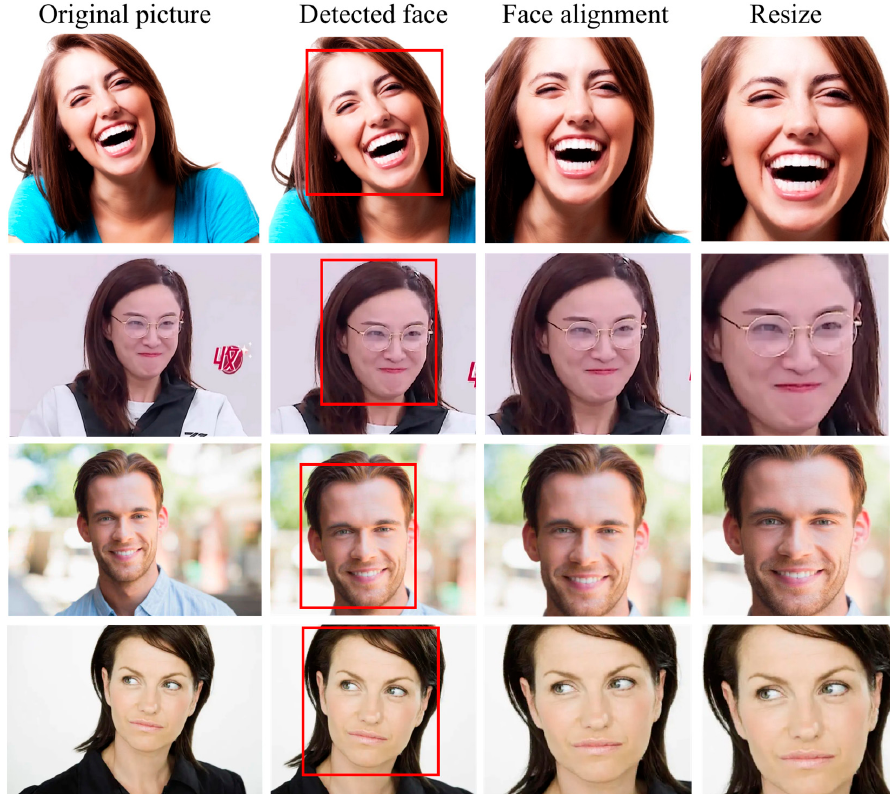
Figure 3. Processing of Facial Expression Emotions.